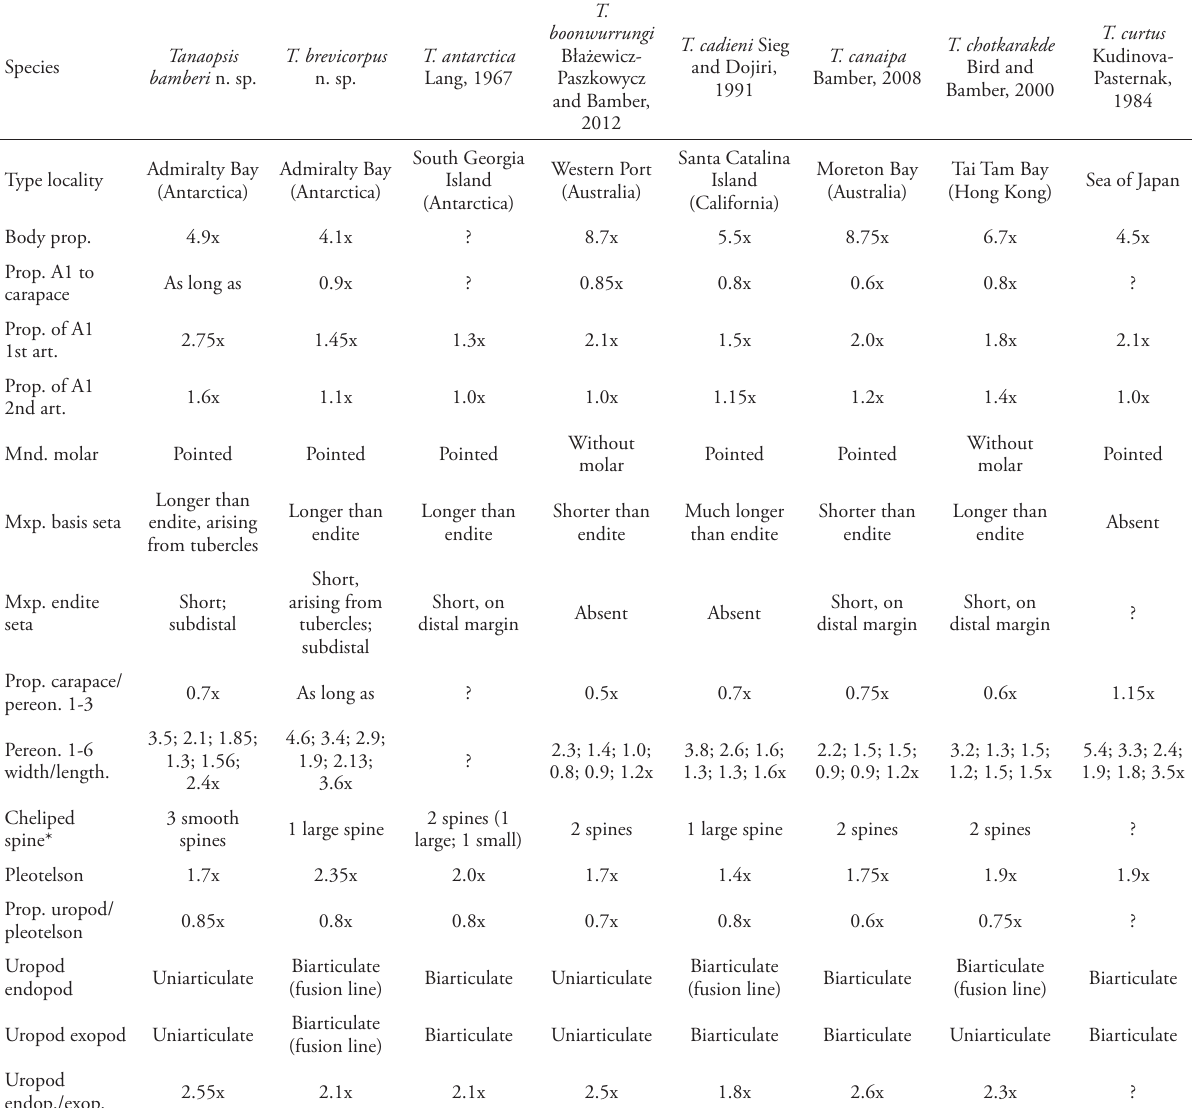
Table 2. List of mainly diagnostic characters of all described species of Tanaopsis Sars, 1899 (based on female morphology). Abbreviations: A1 = antennule; art. = article; mnd. = mandibule; mxp. = maxilliped; pereon. = pereonite; prop. = length/width; endop. = endopod; exop. = exopod. * Form of spiniform process on inner margin of cheliped fixed finger; ? Information not shown in articles cited.